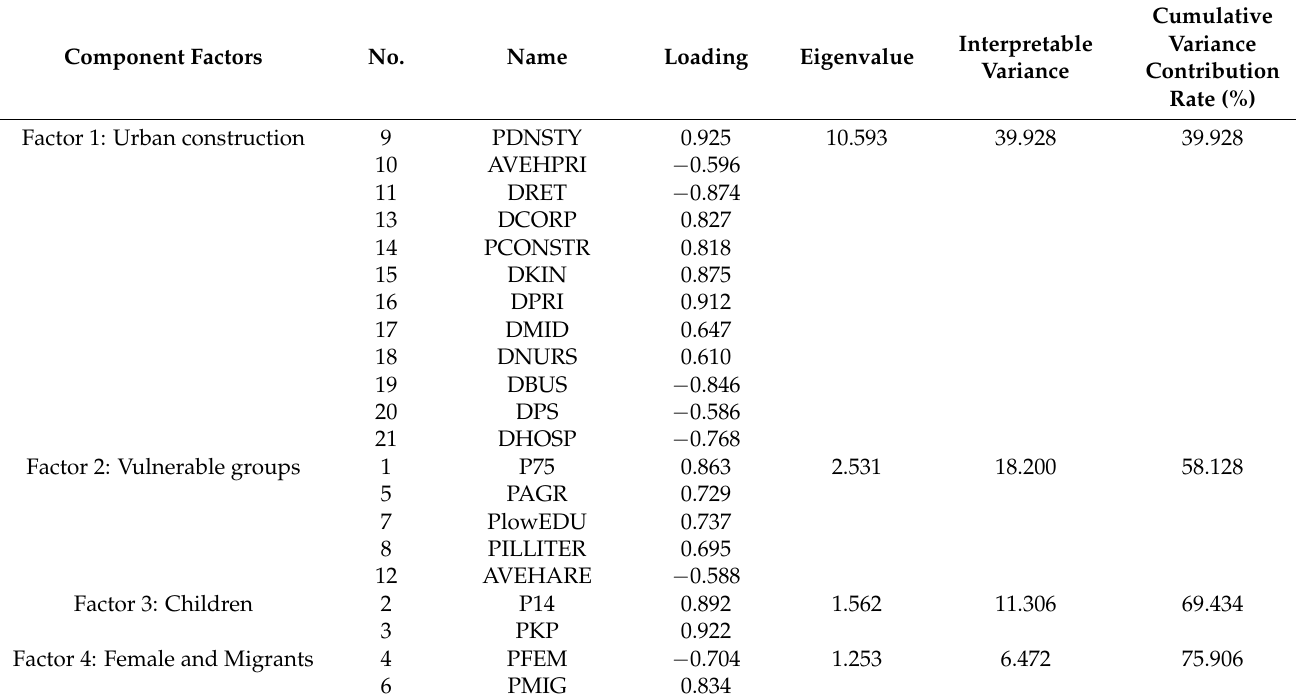
Table 2. Results of PCA: the components, main variables, and their interpretable variances. Component Factors